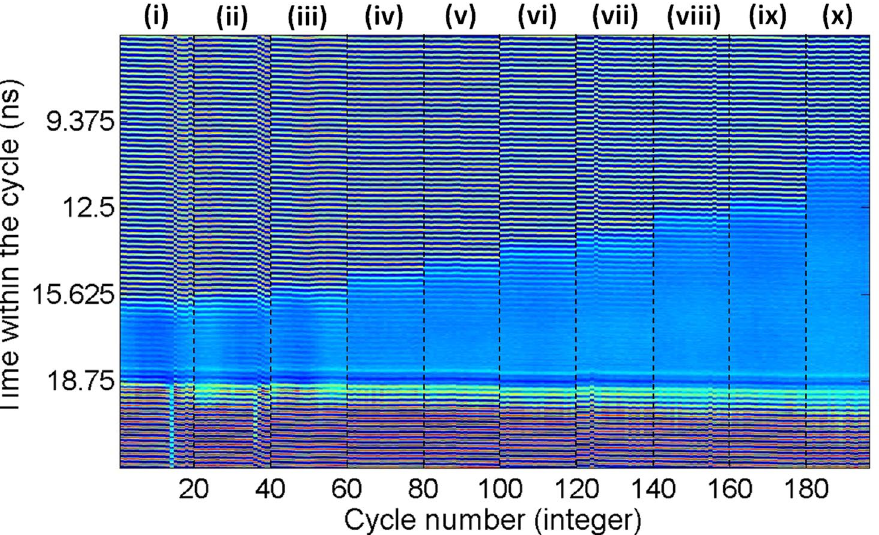
Figure 8. Merged temporal maps obtained for 10 cases of t d : (i) 2.53 ns, (ii) 2.77 ns, (iii) 3.02 ns, (iv) 3.58 ns, (v) 4.08 ns, (vi) 4.73 ns, (vii) 5.11 ns, (viii) 5.88 ns, (ix) 6.36 ns & (x) 8.01 ns. Each map displays the system’s response to 20 consecutive